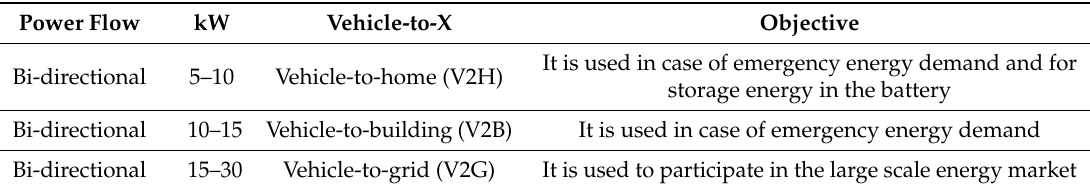
Table 1. Vehicle-to-X energy transfer range